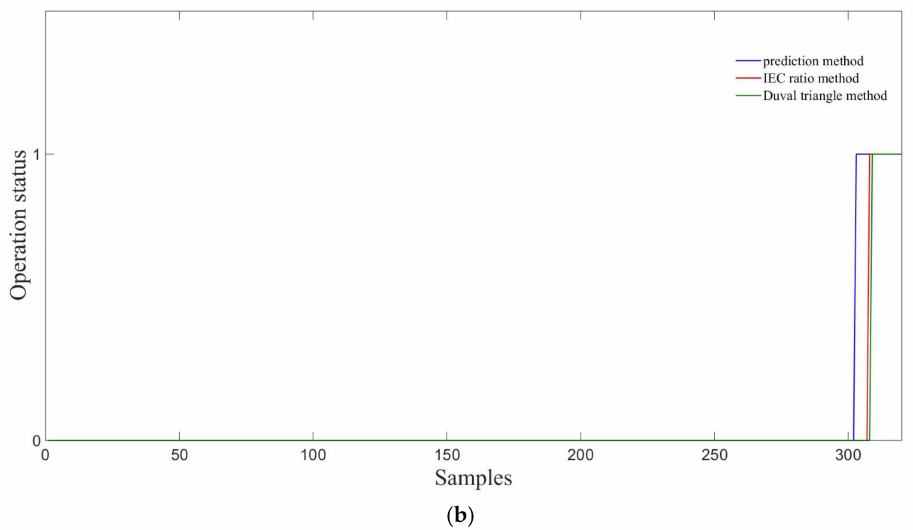
Figure 6. Application in pre-emergency state of the transformer: ( a ) hydrogen gas concentration prediction results ( b ) transformer operation